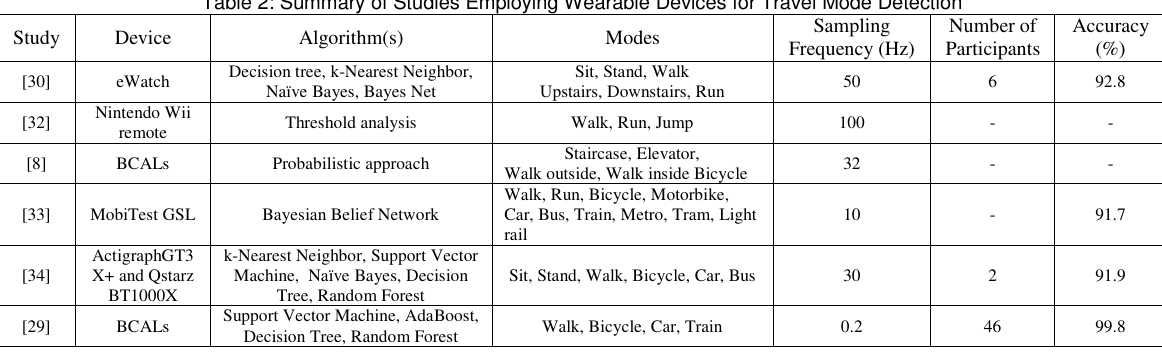
Table 2: Summary of Studies Employing Wearable Devices for Travel Mode